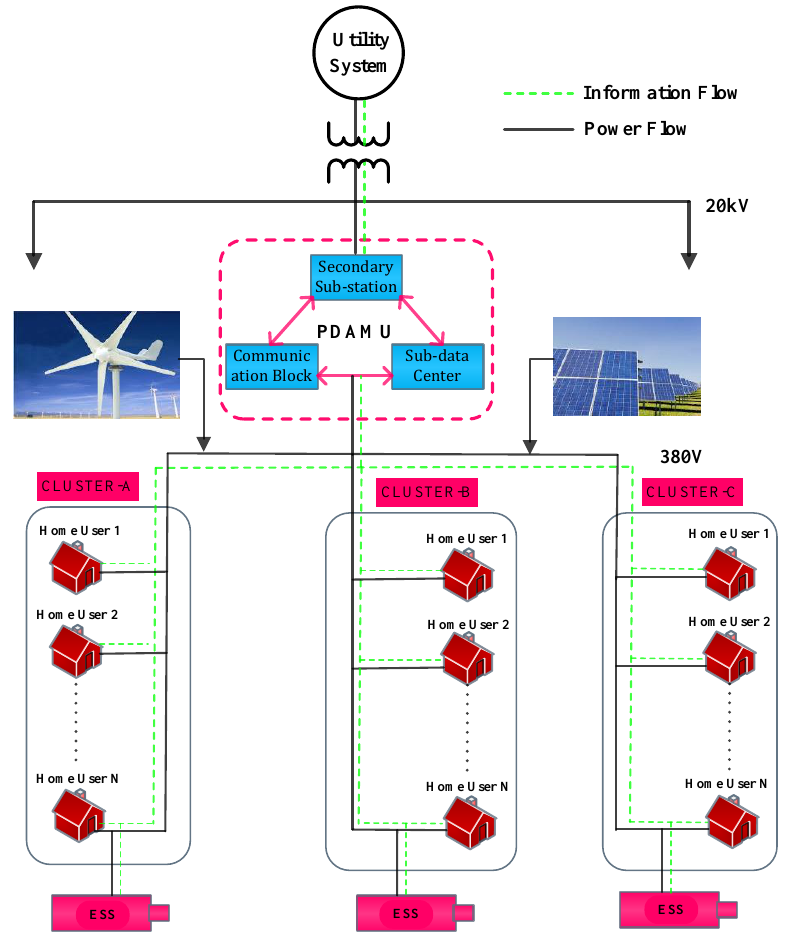
Figure 1. The cluster-based smart grid architecture.